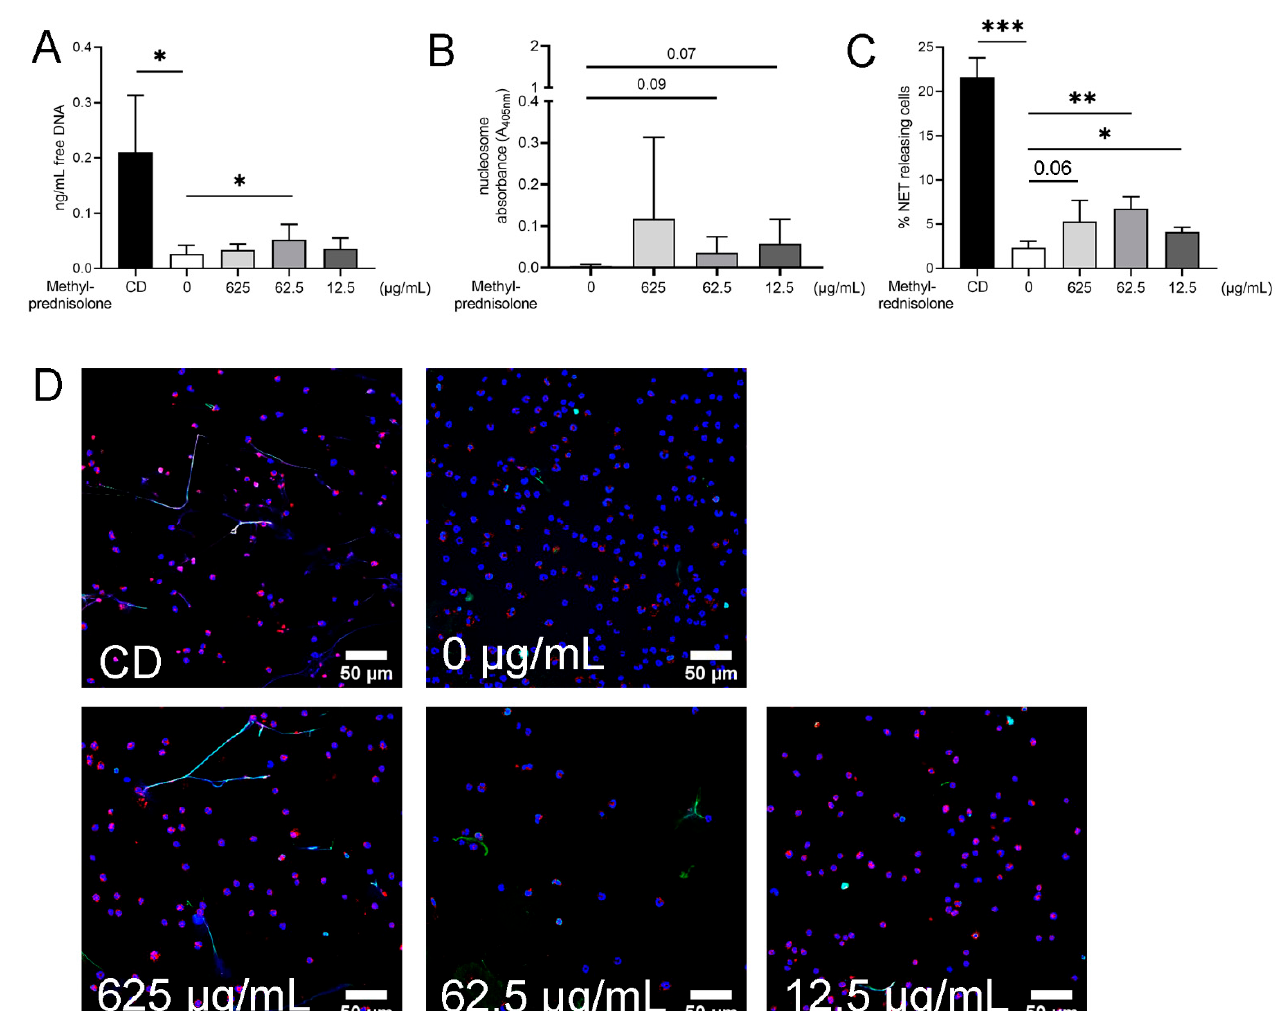
Figure 4. NETs are released from canine neutrophils after three hours of incubation with methylprednisolone in a concentration dependency. ( A ) Free DNA as one marker for NETs was detected in the supernatants of neutrophils incubated for three hours with different concentrations of methylprednisolone. Methyl- β -cyclodextrin ( C , D ) was used as a positive control. ( B ) Nucleosomes, as a further marker for NETs, were detected in the supernatants of neutrophils incubated for three hours with different concentrations of methylprednisolone. ( C , D ) By immunofluorescence microscopy, neutrophils were analyzed for NET release (green = DNA/histone ‐ 1 complexes, red = myeloperoxidase and blue = DNA). Per sample, six pictures were taken on two slides at predefined positions and the number of NET ‐ releasing cells were determined by counting for statistical analysis. The settings were adjusted to a respective isotype control. Representative overlay pictures are presented in C. All graphs show the mean ± SD of n = 4 independent experiment and statistical differences were detected by one-tailed paired Student’s t ‐ test. Statistical results are presented for values lower than 0.1 and higher than 0.05 as Arabic numbers and as the following: *, p < 0.05; **, p < 0.01; ***, p < 0.001. In C at 12.5 μ g/mL, one outlier was excluded after analysis with Grubbs’ test.